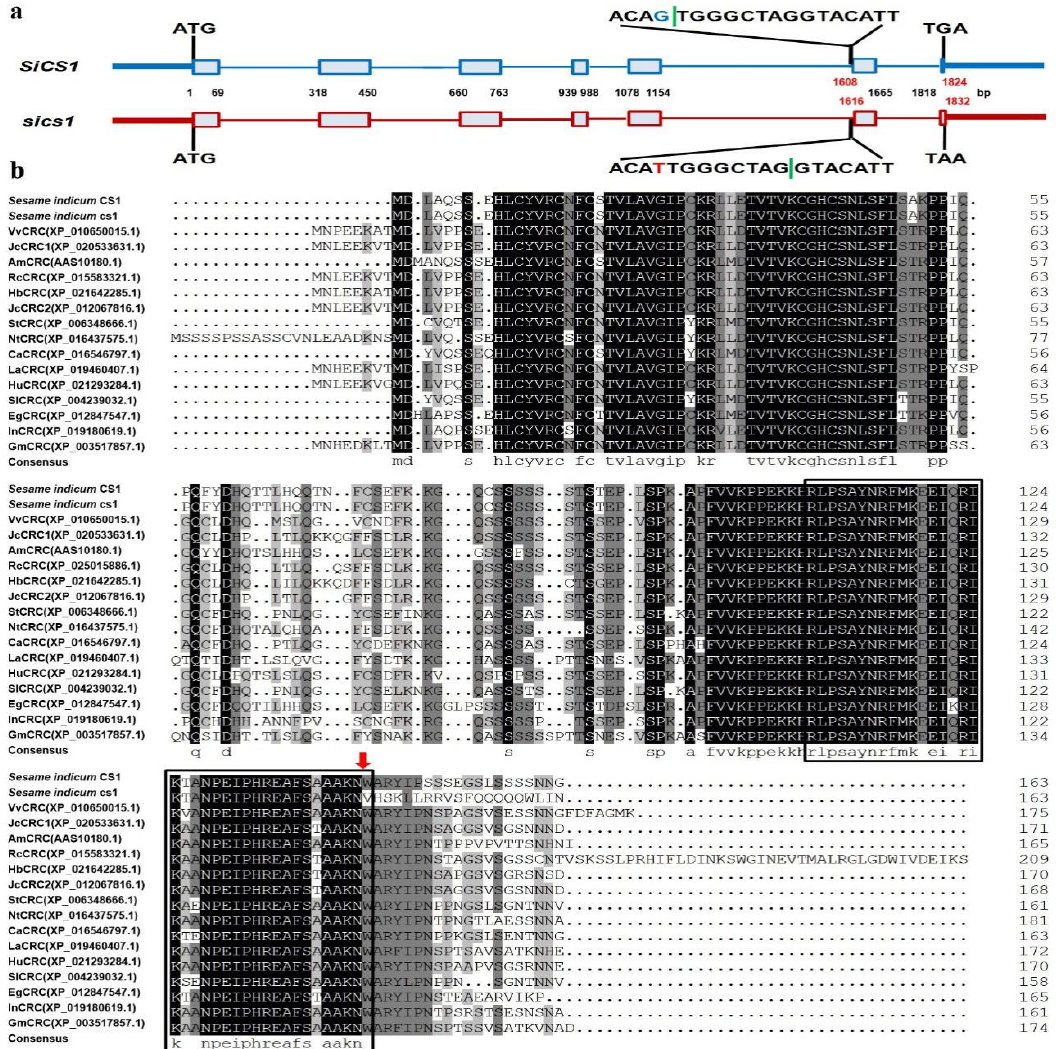
Figure 5. Structure analysis and sequence comparison of SiCS1 and Sics1 homologs in sesame and other plant species. ( a ): Structure comparison of SiCS1 and Sics1 . ( b ): Protein sequence comparison of SiCS1 and Sics1 homologs in sesame and other plant species. The box in b labeled HMGB-UBF_HMG-box conserved domain. The red arrow indicates the mutation site. Note: the green vertical lines refer to the splicing point. The blue G and red T refer to SNP variant between SiCS1 and Sics1.